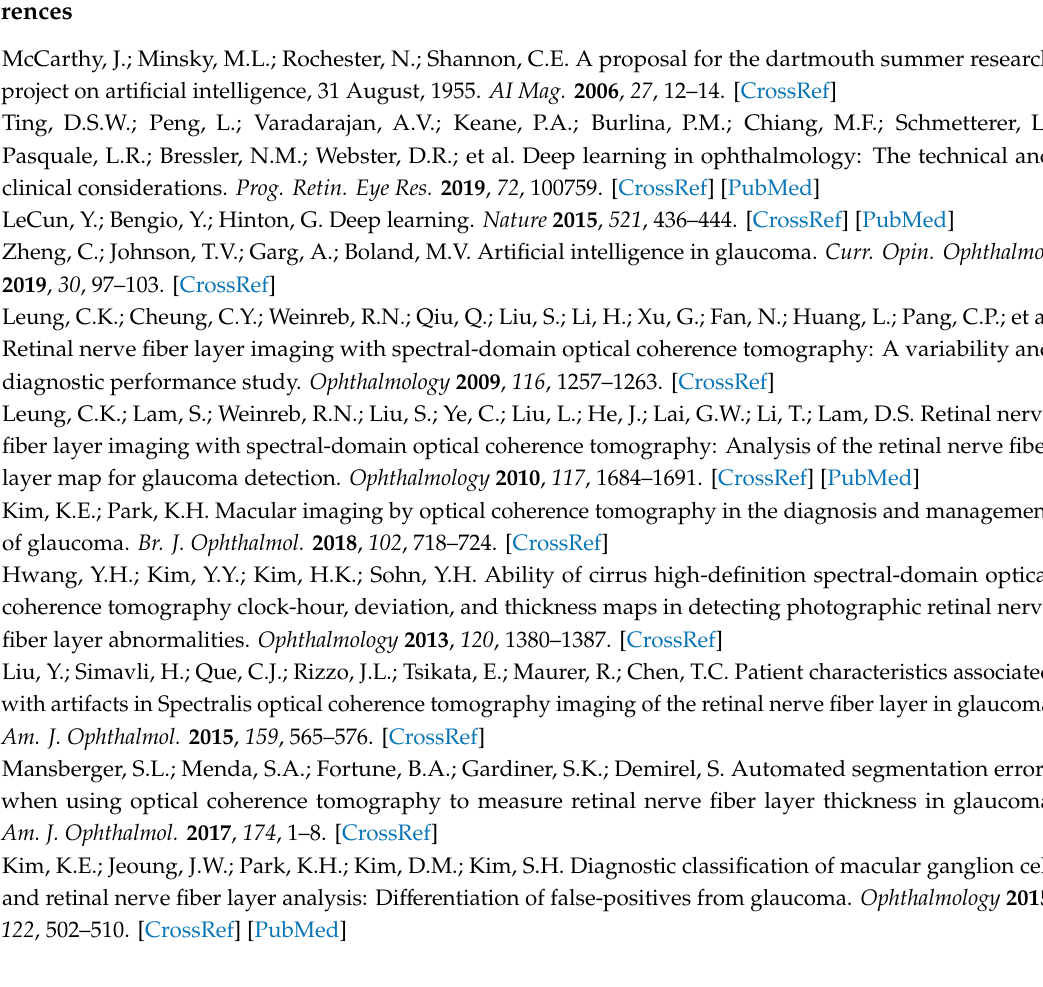
Table S1: Glaucoma diagnostic ability of deep learning system using retinal nerve fiber layer (RNFL) and ganglion cell–inner plexiform layer (GCIPL) spectral-domain optical coherence tomography maps when testing the external validation